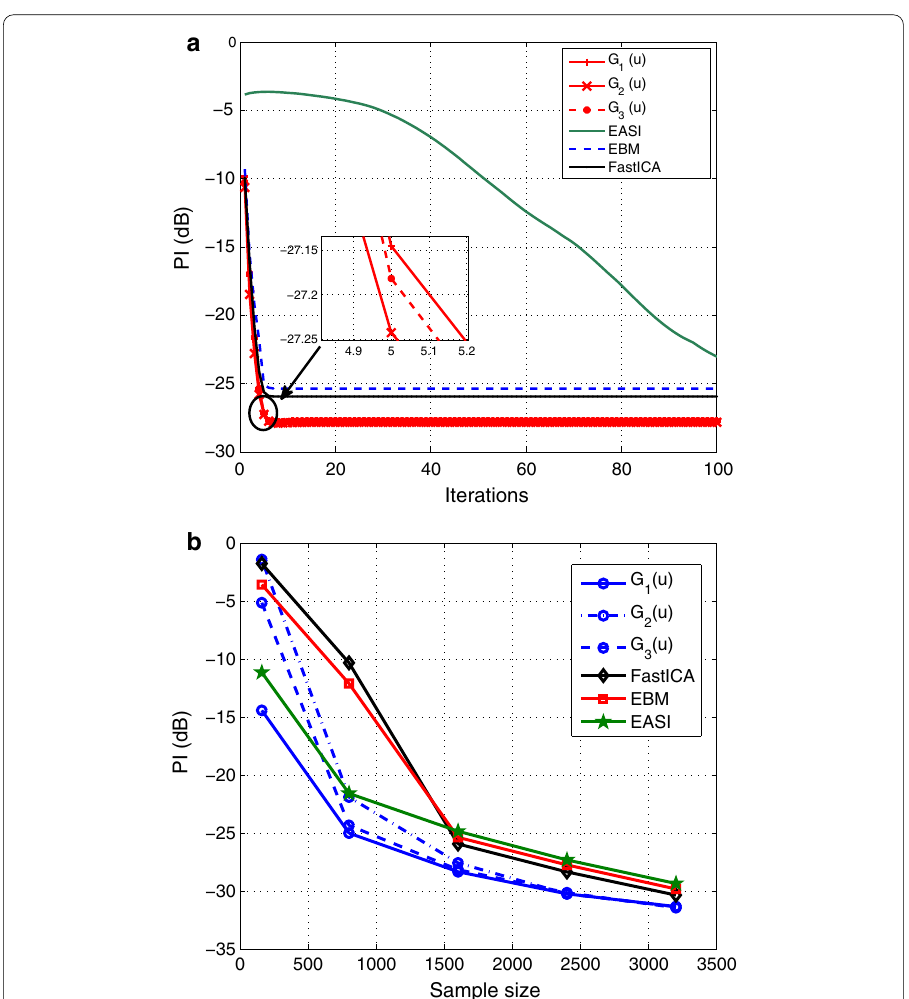
Fig. 3 a Comparison of average PIs over 100 independent runs for the four algorithms. b Comparison of average PIs of the four algorithms over 100 independent runs at different sample size for 8PSK